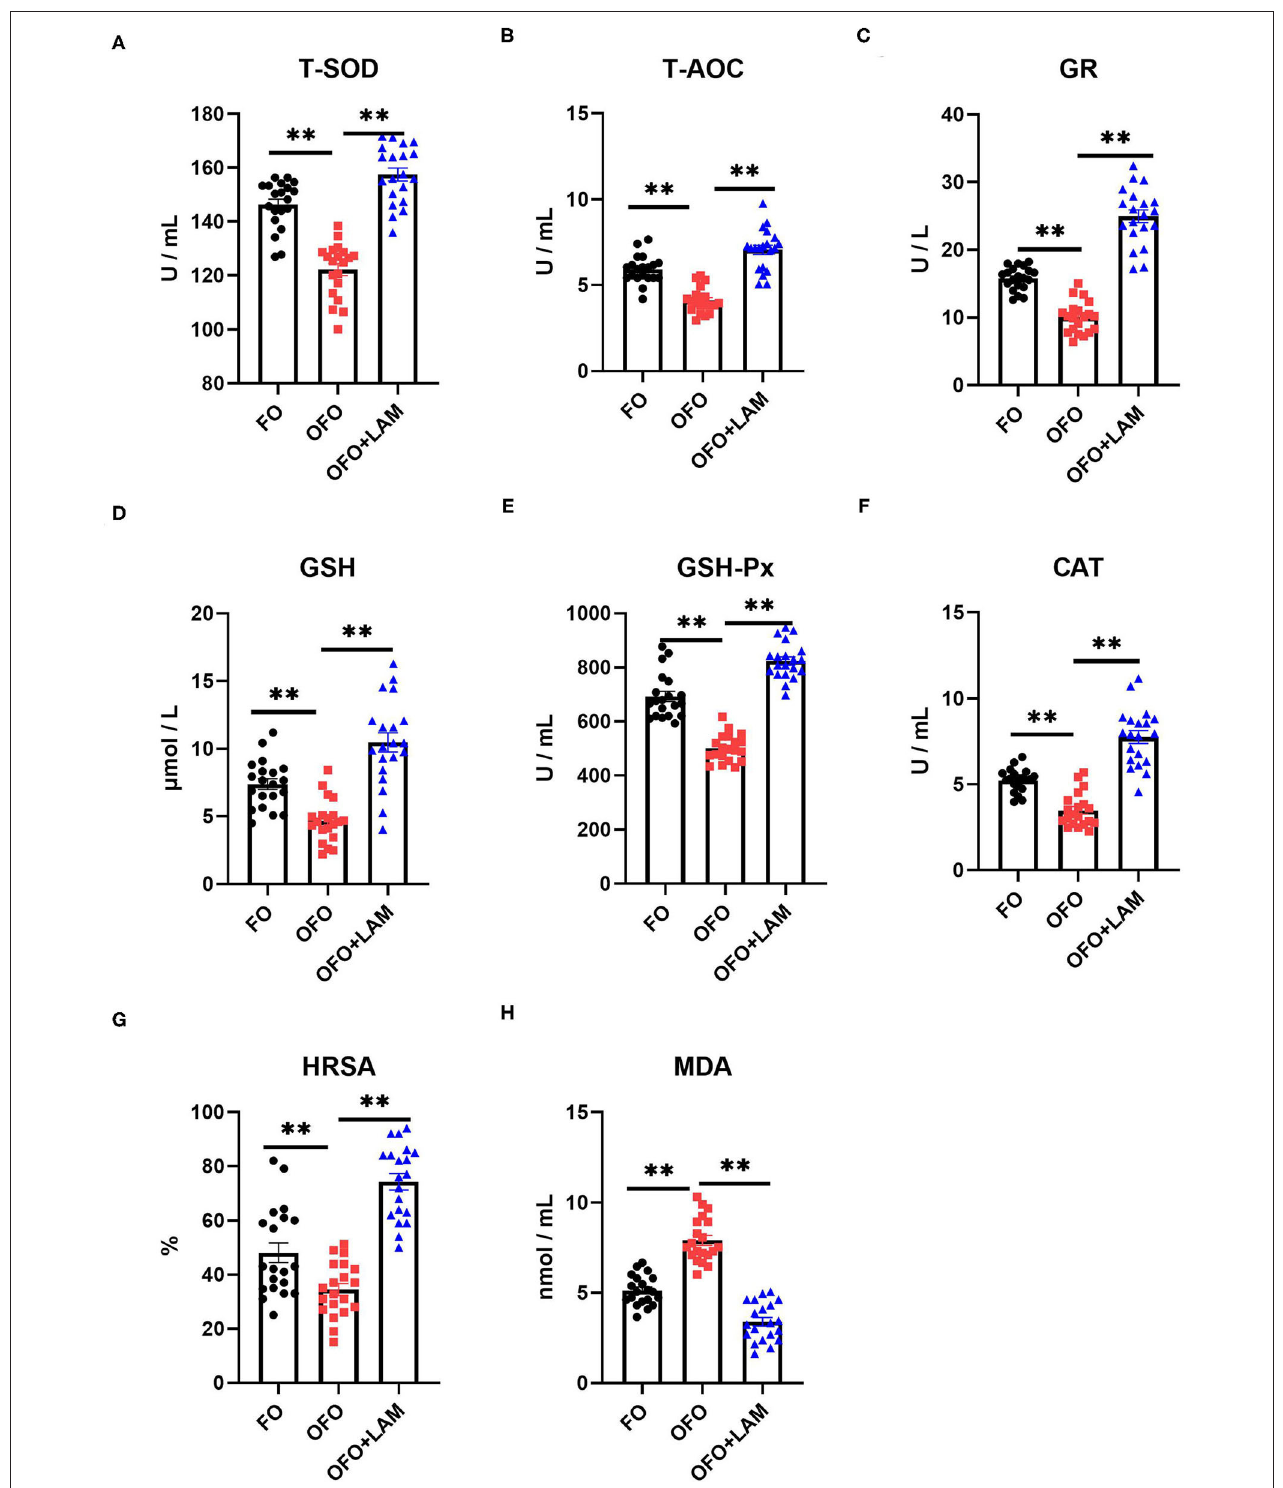
FIGURE 4 | The effect of FO, OFO, and OFO with LAM on serum oxidative stress parameters. (A) Content of total superoxide dismutase (T-SOD) in FO, OFO, and OFO + LAM. (B) Content of total antioxidant (T-AOC) in FO, OFO, and OFO + LAM. (C) Content of glutathione reductase (GR) in FO, OFO, and OFO + LAM. (D) Content of glutathione (GSH) in FO, OFO, and OFO + LAM. (E) Content of glutathione peroxidase (GSH-Px) in FO, OFO, and OFO + LAM. (F) Content of catalase (CAT) in FO, OFO, and OFO + LAM. (G) Content of hydroxyl radical scavenging activity (HRSA) in FO, OFO, and OFO + LAM. (H) Content of malondialdehyde (MDA) in FO, OFO, and OFO + LAM. ** p < 0.01 indicate significant differences between the two groups.